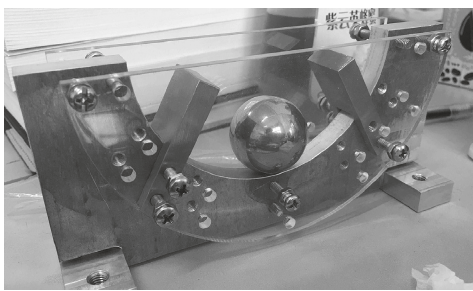
Figure 24: Experiment model of PTRMD. Table 4: Parameters of PTRMD in test.